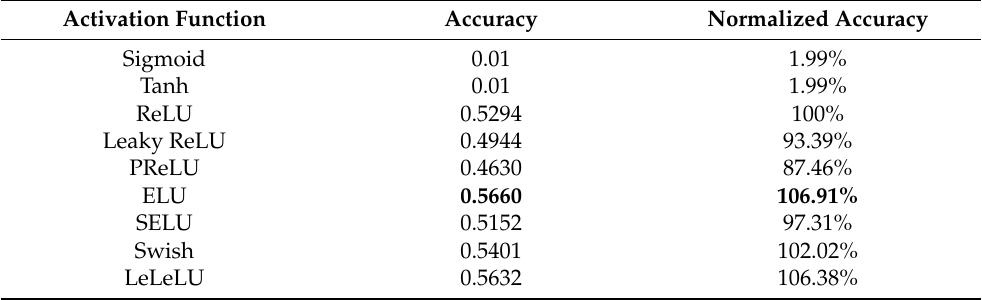
Table 6. Test accuracy in the CIFAR-100 dataset of the activation functions in question, using the VGG-16 neural network, and accuracy normalized to that attained by ReLU activation function.